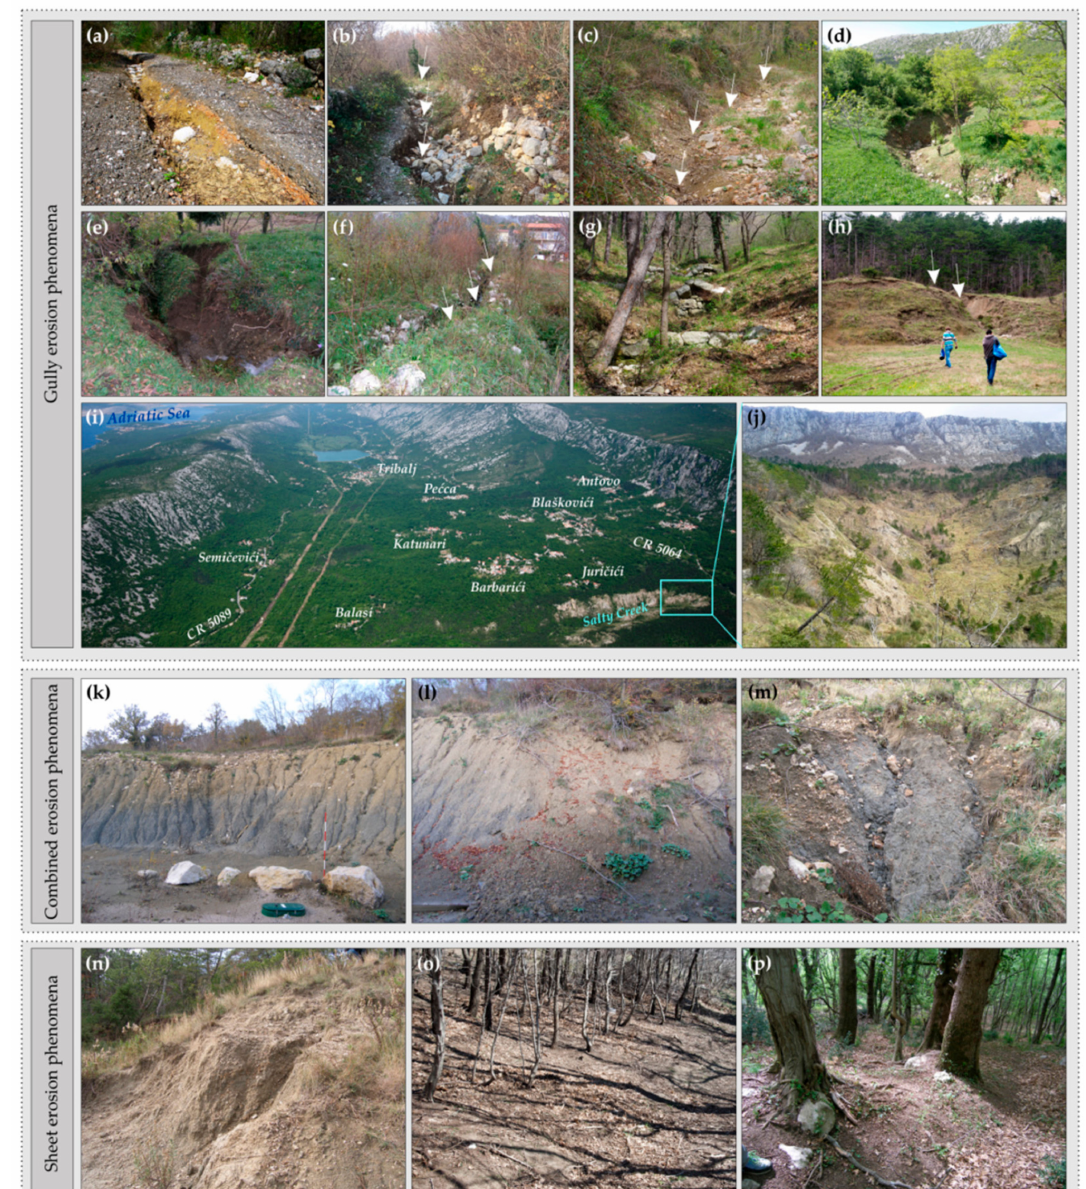
Figure 2. Photographs of erosion phenomena identified in the Vinodol Valley. The gully erosion phenomena formed along: ( a ) the local road, ( b , c ) pathways, ( d , e ) agricultural terraces, and ( f ) their boundaries; ( g ) an example of the stone check dam built to control the gully erosion; ( h ) a gully formed under the forest; ( i ) a view from the air of the central part of the Vinodol Valley, with depicted detail of the Slani Potok gully, shown in ( j ). ( k – m ) The combined erosion phenomena characterized by the small drainage network associated with colluvial deposits; ( n ) the sheet erosion phenomena formed in eluvial deposits, and in ( o ) the forest, as indicated by the exposed tree roots ( p ). Apart from the soil erosion, traces of past and recent human activities (i.e., agricultural terraces, roads, pathways), as well as the topographic signatures of diverse geological materials, are present along the surface of almost the entire study area, and they are clearly expressed on the LiDAR imagery (Figure 3a). Most of the agricultural terraces, which were built in the historical time along the flysch slopes for vineyards [59], are currently abandoned and covered by dense forests (Figure